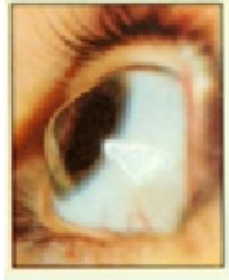
Figure 2. Keratoconus eye.